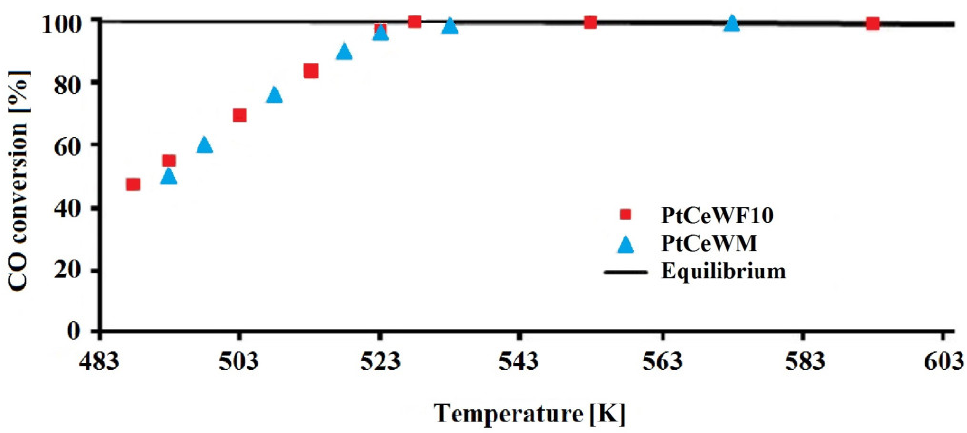
Figure 3. Evaluation of the activity of the two structured catalysts at WHSV = 1.2 g CO /g cat /h −1 (contact time τc = 360 ms).